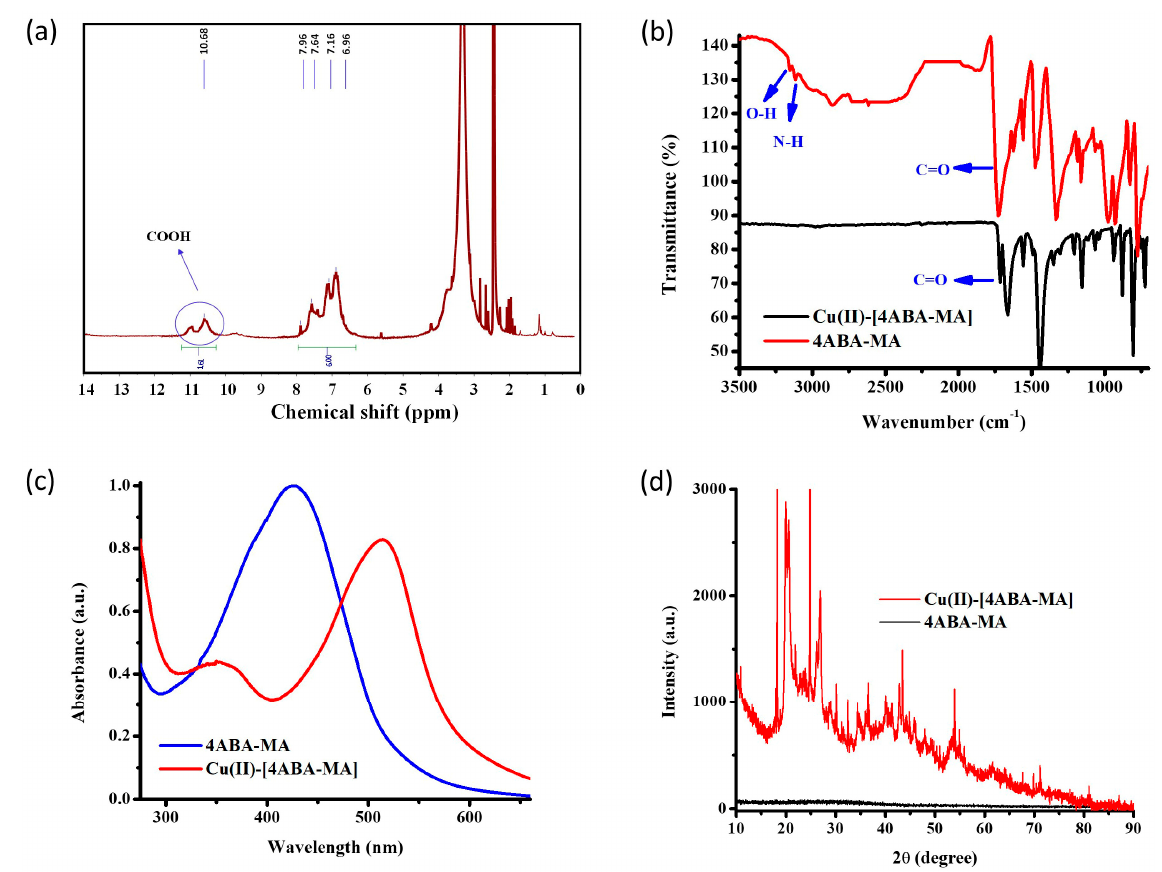
Figure 2. Chemical structural characterization of 2D MOF: ( a ) 1 H NMR spectrum of 4ABA − MA in DMSO and ( b ) FTIR of 4ABA − MA and Cu(II) − [4ABA − MA] MOF. ( c ) UV − visible spectrum of 4ABA − MA and Cu(II) − [4ABA − MA] ( d ) PXRDof 4ABA − MA and Cu(II) − [4ABA − MA] MOF.